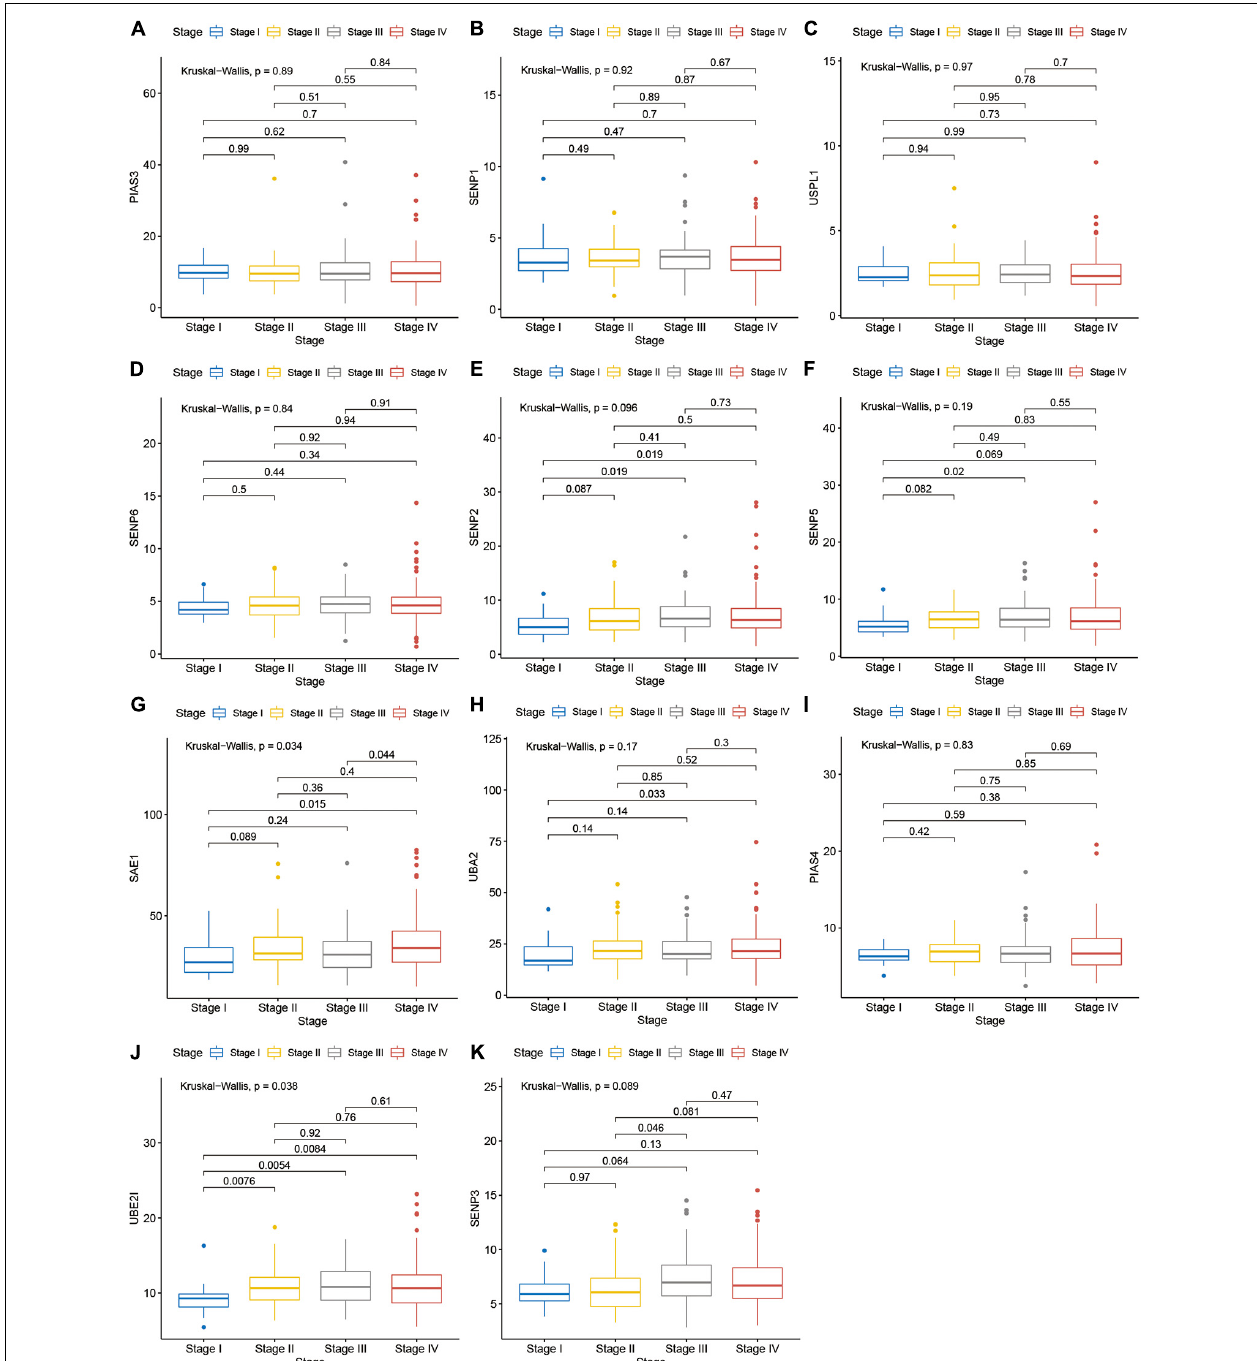
FIGURE 3 | SAE1 and UBE2I had differential expressions with different stages. (A) PIAS3; (B) SENP1; (C) USPL1; (D) SENP6; (E) SENP2; (F) SENP5; (G) SAE1; (H) UBA2; (I) PIAS4; (J) UBE2I; (K) SENP3 in different